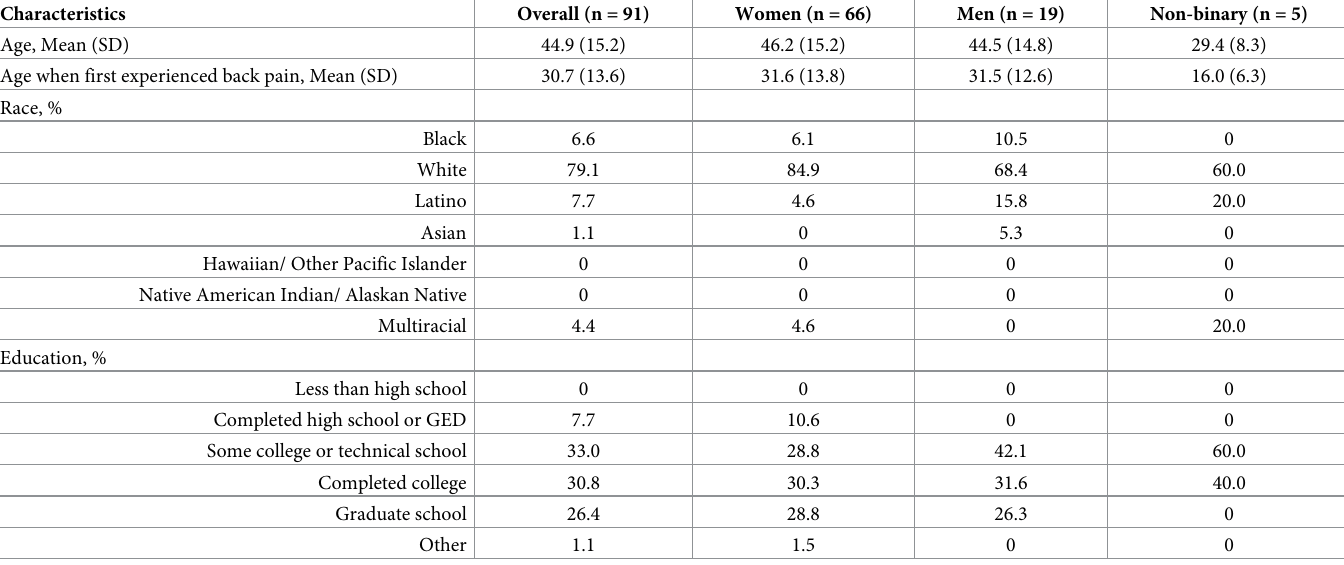
Table 1. Sample characteristic of study participants.